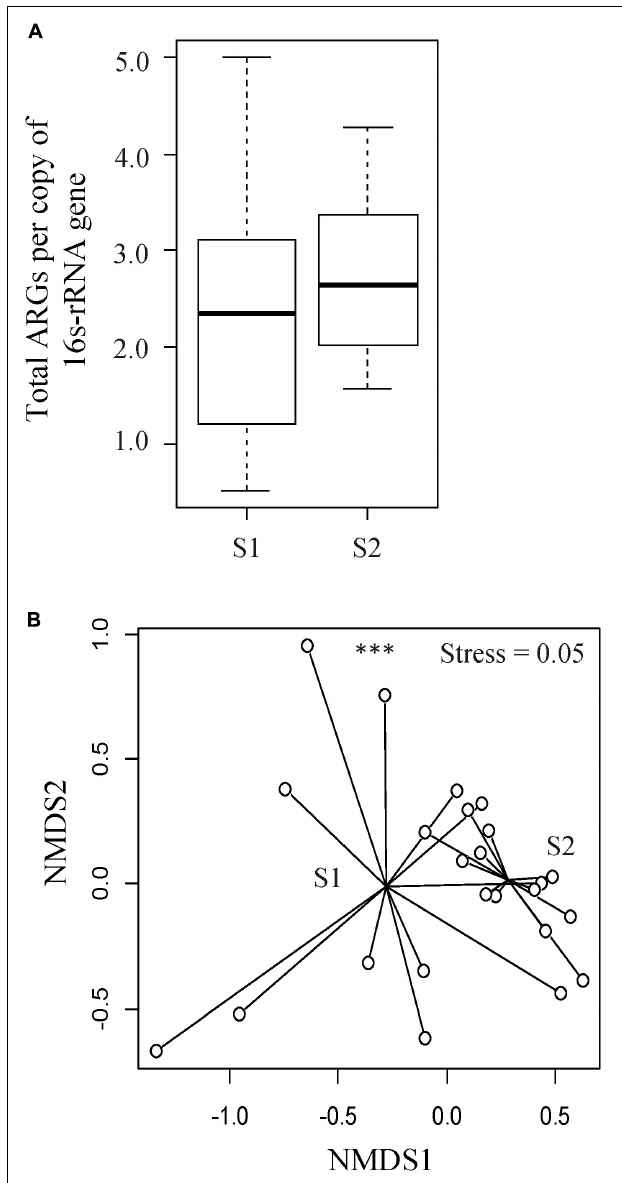
FIGURE 3 | Evaluation of resistome profiles in feces collected from veal calves soon after they were brought onto the farms (Sampling 1/S1, n = 12) and fecal samples from the same cohort of calves at slaughter-age (Sampling 2/S2, n = 12). (A) Boxplots of the relative abundances of 16S rRNA-normalized ARGs. (B) Non-metric multidimensional scaling (NMDS) plot based on Bray-Curtis distance matrix of ARG families from the two stages of veal production. Triple asterisks ( ∗∗∗ ) represent statistical significance with p < 0.001, double asterisks ( ∗∗ ) represent p < 0.01, a single asterisk ( ∗ ) represents p < 0.05, and no asterisk represents no statistical significance were observed.